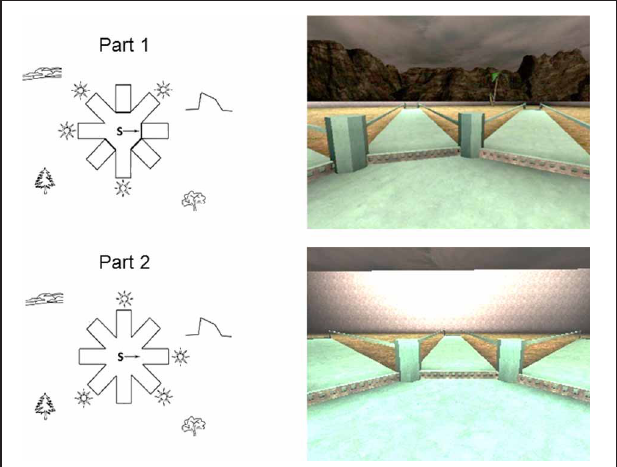
FIGURE 1 | Schematic drawings (left) and first person views (right) of the adult 4/8VM